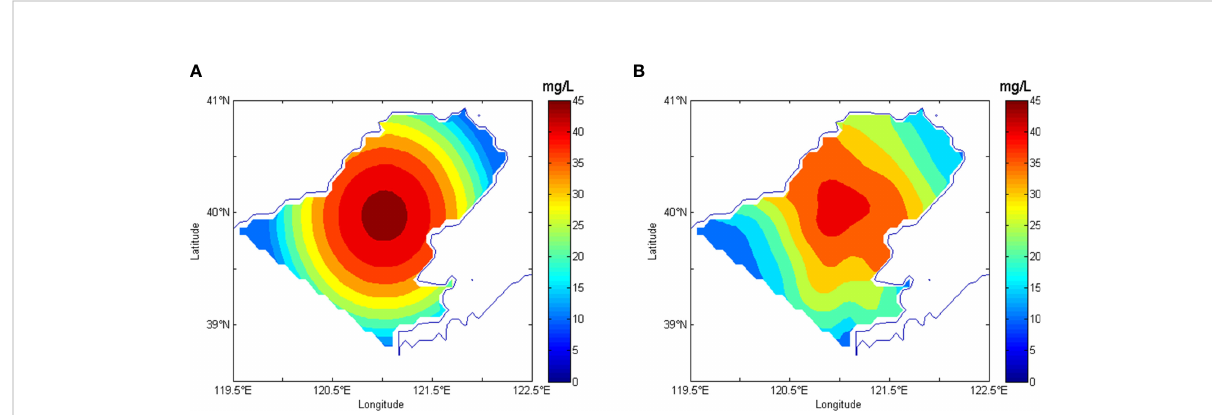
FIGURE 3 Interpolated results of given initial distribution of SPM that shows a parabolic surface with downward convex. (A) is the given distribution in Ideal Experiment I. (B) is interpolated distribution derived from dynamically constrained interpolation. The observations using in the interpolation were picked up from the model-generated concentrations based on given